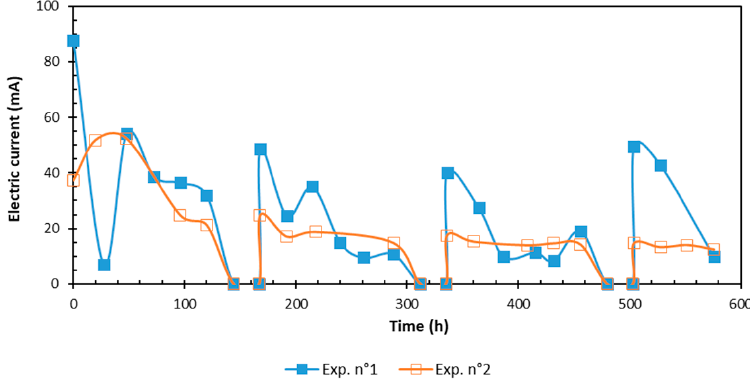
Figure 1. Time evolution of the electric current.